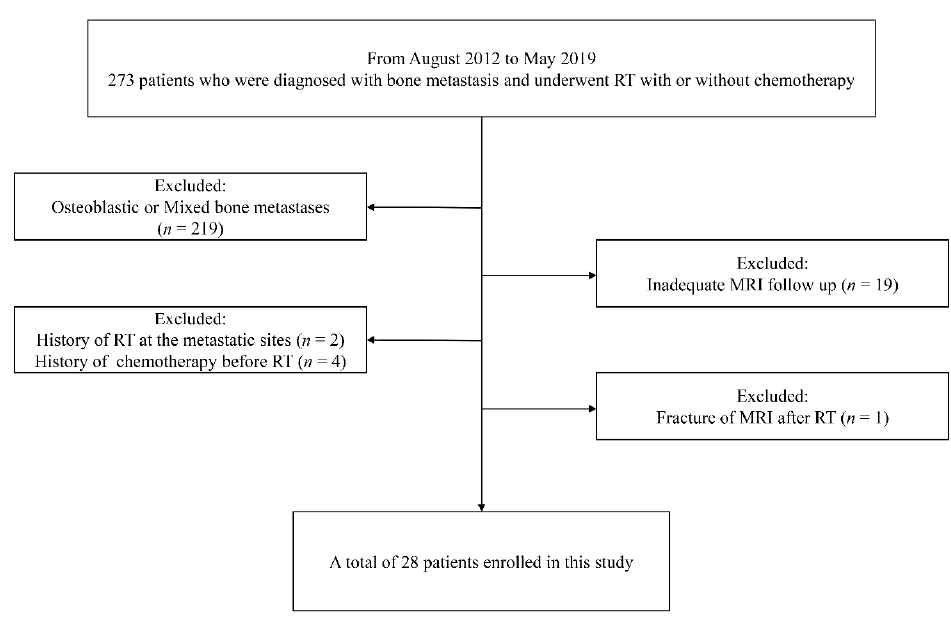
Figure 1. Patient selection flow chart. RT, radiation therapy. Finally, 28 patients were enrolled in the study. All clinical data, including age, sex, primary cancer, and RT dose, were retrospectively obtained from medical